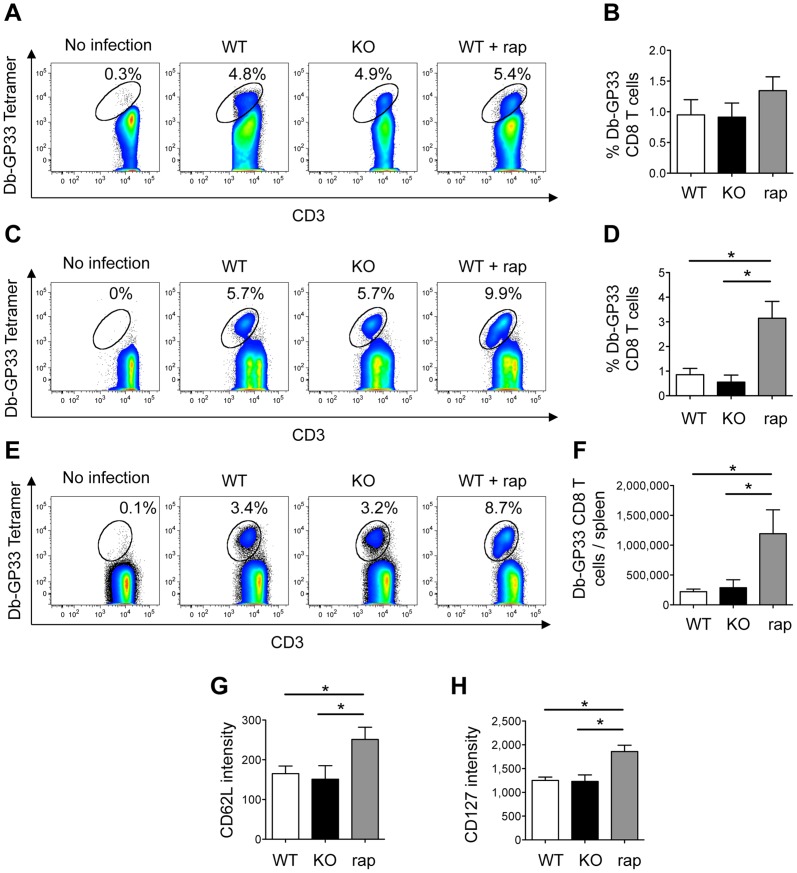
Normal effector and memory CD8+ T cell response to LCMV in KSR1-deficient mice.WT, KSR1-/-, and WT mice treated with rapamycin were infected with 105 pfu of LCMV-Armstrong, and presence of GP33 epitope specific CD8+ T cells was analyzed by flow cytometry 7 (A, B) and 30 (C–H) days after infection in the blood (A–D) and spleen (E–H). A, C, E: Percentage of Db-GP33 Tetramer positive cells in CD8+ T cells. Plots are representative of two experiments with 5 mice per group. B, D: Percentage of Db-GP33 Tetramer+ CD8+ T cells in peripheral blood mononuclear cells. F: Number of Db-GP33 Tetramer+ CD8+ T cells per spleen 30 days after infection. G, H: CD62L and CD127 expression in Db-GP33 Tetramer+ CD8+ T splenocytes 30 days after infection. Data is presented as mean + SEM and is representative of two experiments with 5 mice per group. *: p<0.05, t-test.